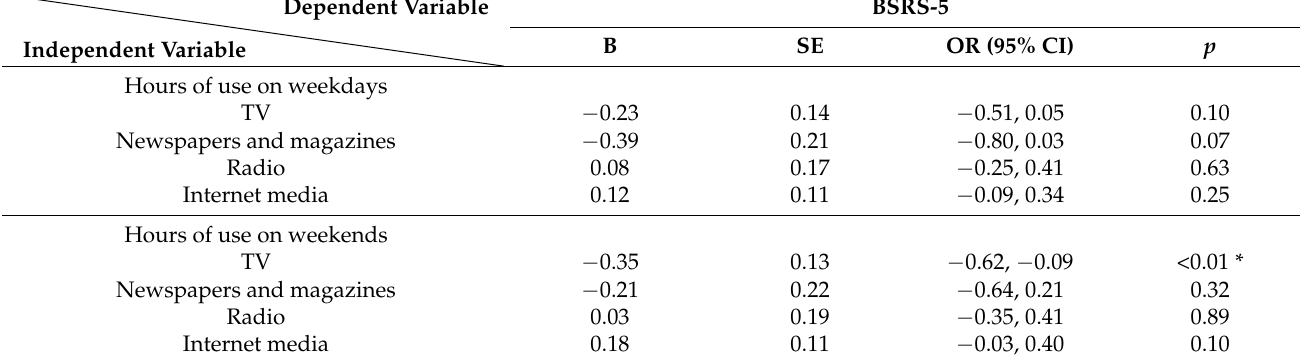
Table 4. Multiple regression analysis for identifying depression significantly related to the hours of media usage on weekdays † /weekends †